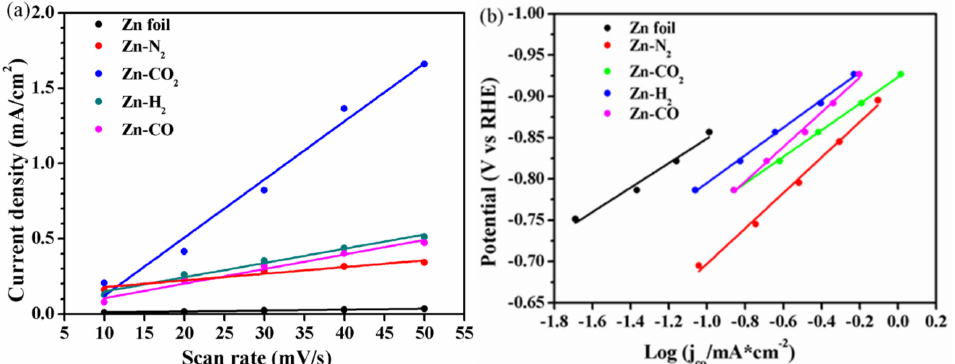
Figure 7. ( a ) The line regression of the double layer capacitance and ( b ) Tafel Plot for CO 2 RR